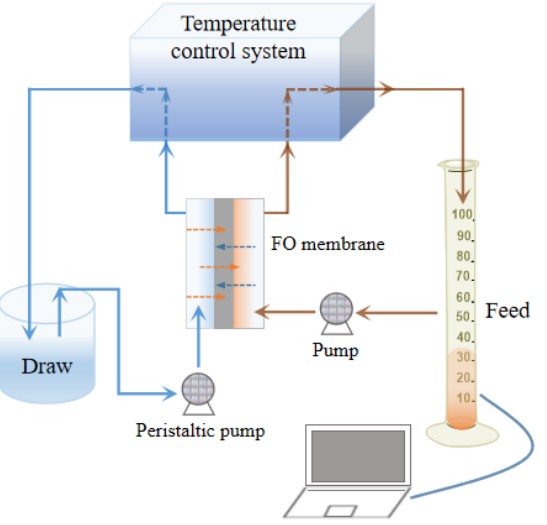
Figure 5. Water flux measurement graph of PNIPAAm microgel modified with P4VP.